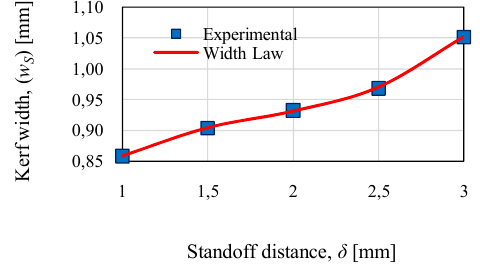
Figure 4. KW variation on top region